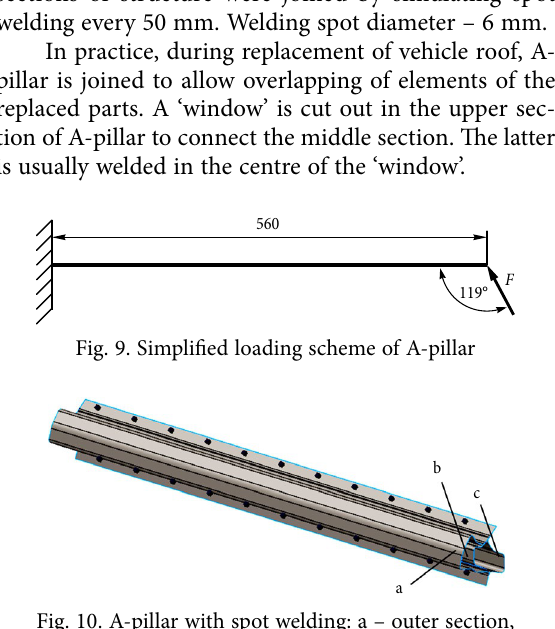
Fig. 10. A-pillar with spot welding: a – outer section, b – middle section, c – inner